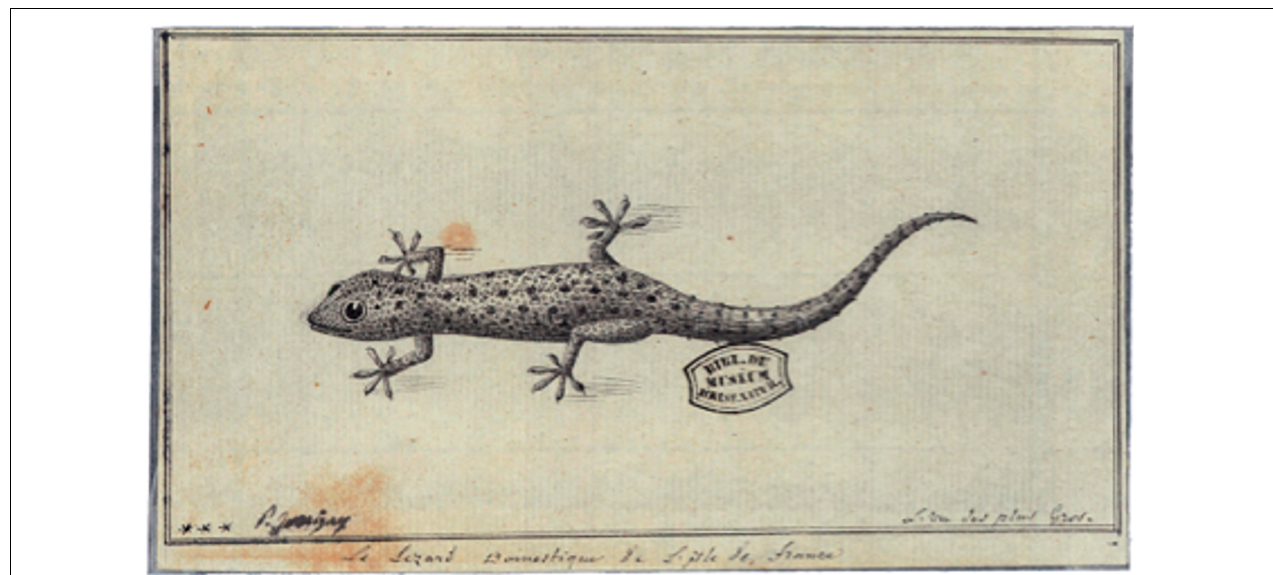
FIGURE 2 | An image of Hemidactylus frenatus, Mauritius. Sketch by Paul Philippe Sanguin de Jossigny c.1770 (from Bour